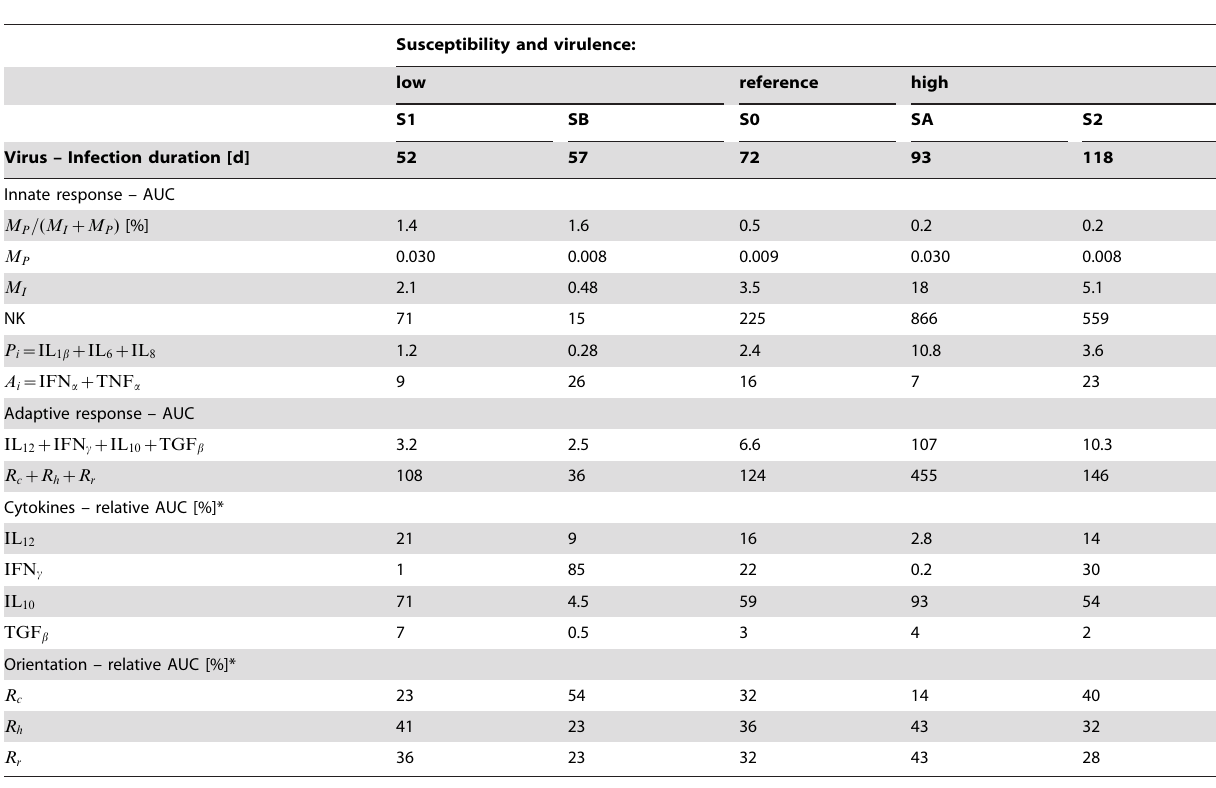
Table 4. Summary of the virus and immune dynamics for variable host susceptibility and strain virulence.